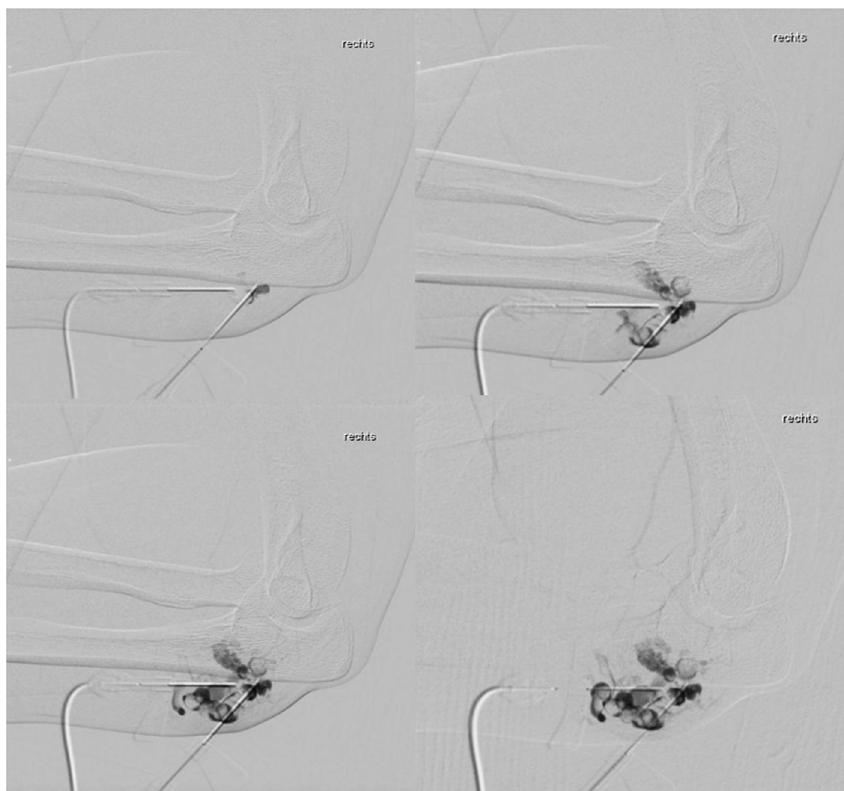
Fig. 5 Slow filling of a VM of the right elbow after contrast medium injection